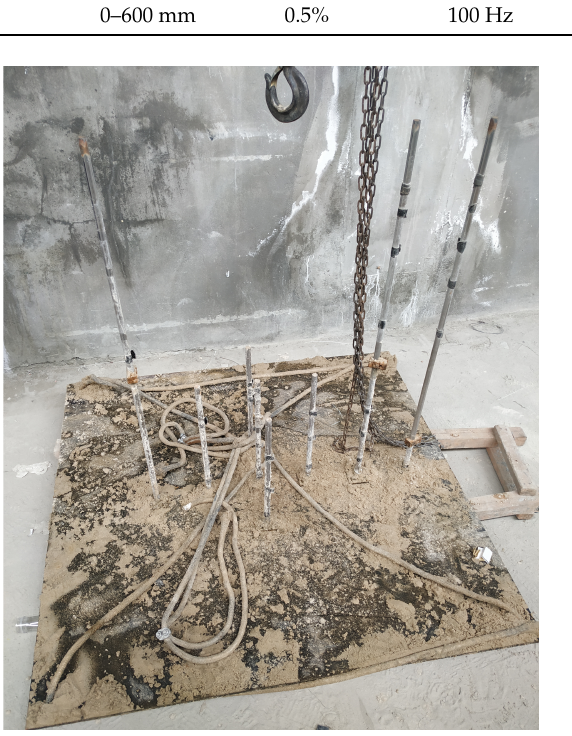
Figure 4. The pressure transducer